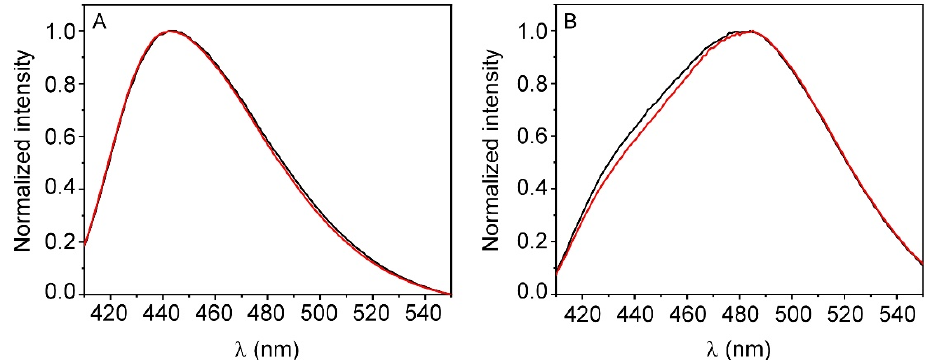
Figure 3. Fluorescence emission spectra of Laurdan ( λ exc = 390 nm) in 1,2-dimyristoyl-sn-glycero-3-phosphocholine (DMPC) LUVs (0.5 mM) in water before (black) and after addition (red) of TMZ (150 μ M), at 15 °C ( A ) and 37 °C ( B ).